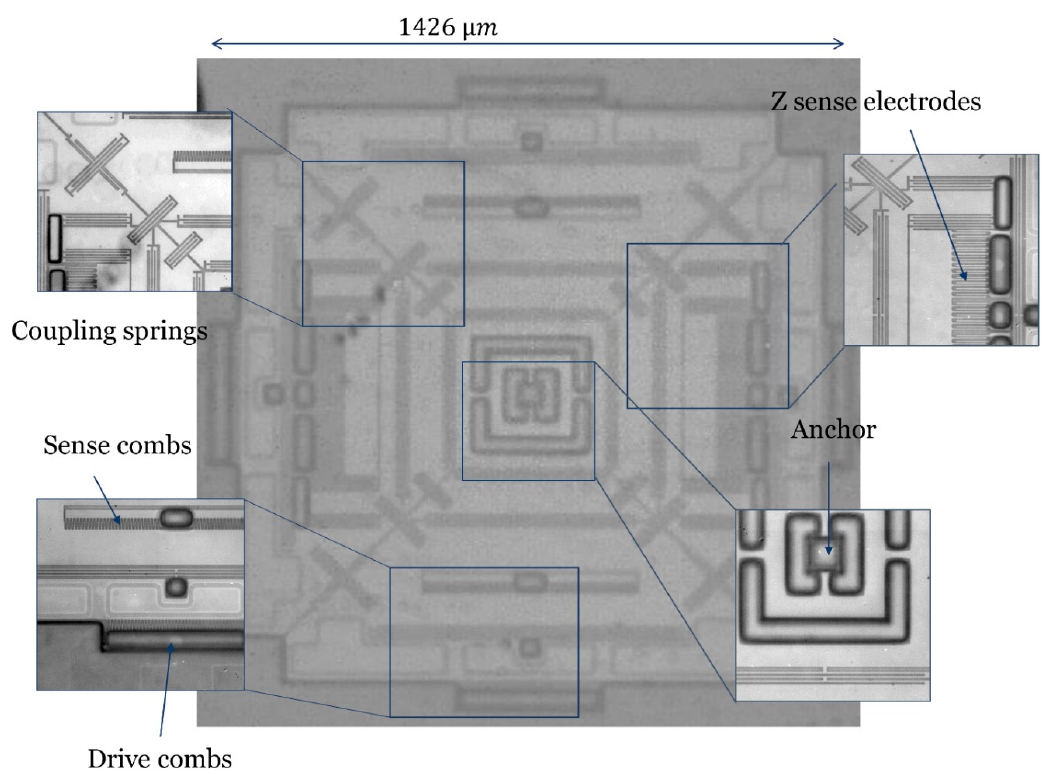
Figure 4. Optical photograph (captured by EMI PHEMOS-1000, Hamamatsu Photonics, Hamamatsu, Japan) of the vacuum packaged single drive multi-axis gyroscope.